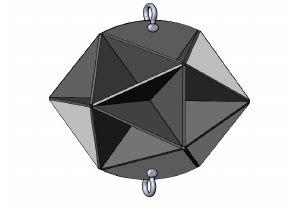
Figure 10. Sonar target Multi-triplane